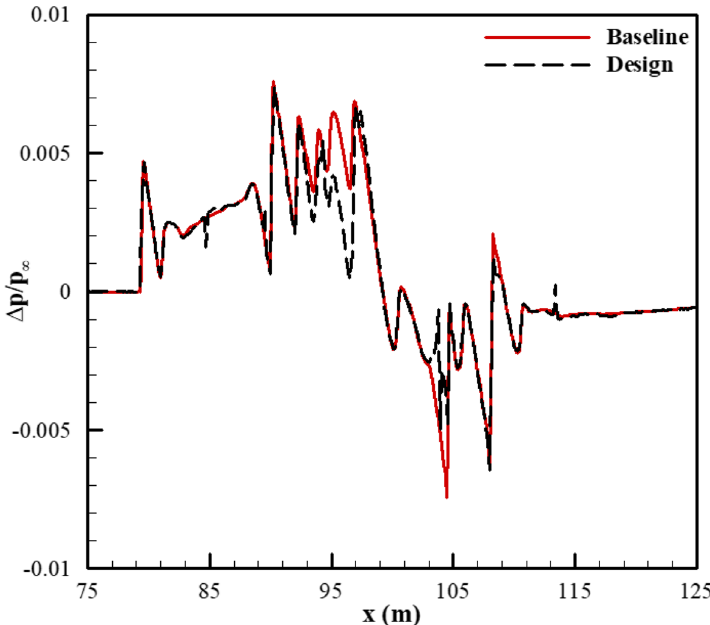
Fig. 20 Optimized near-field signature matching a physically non-existent